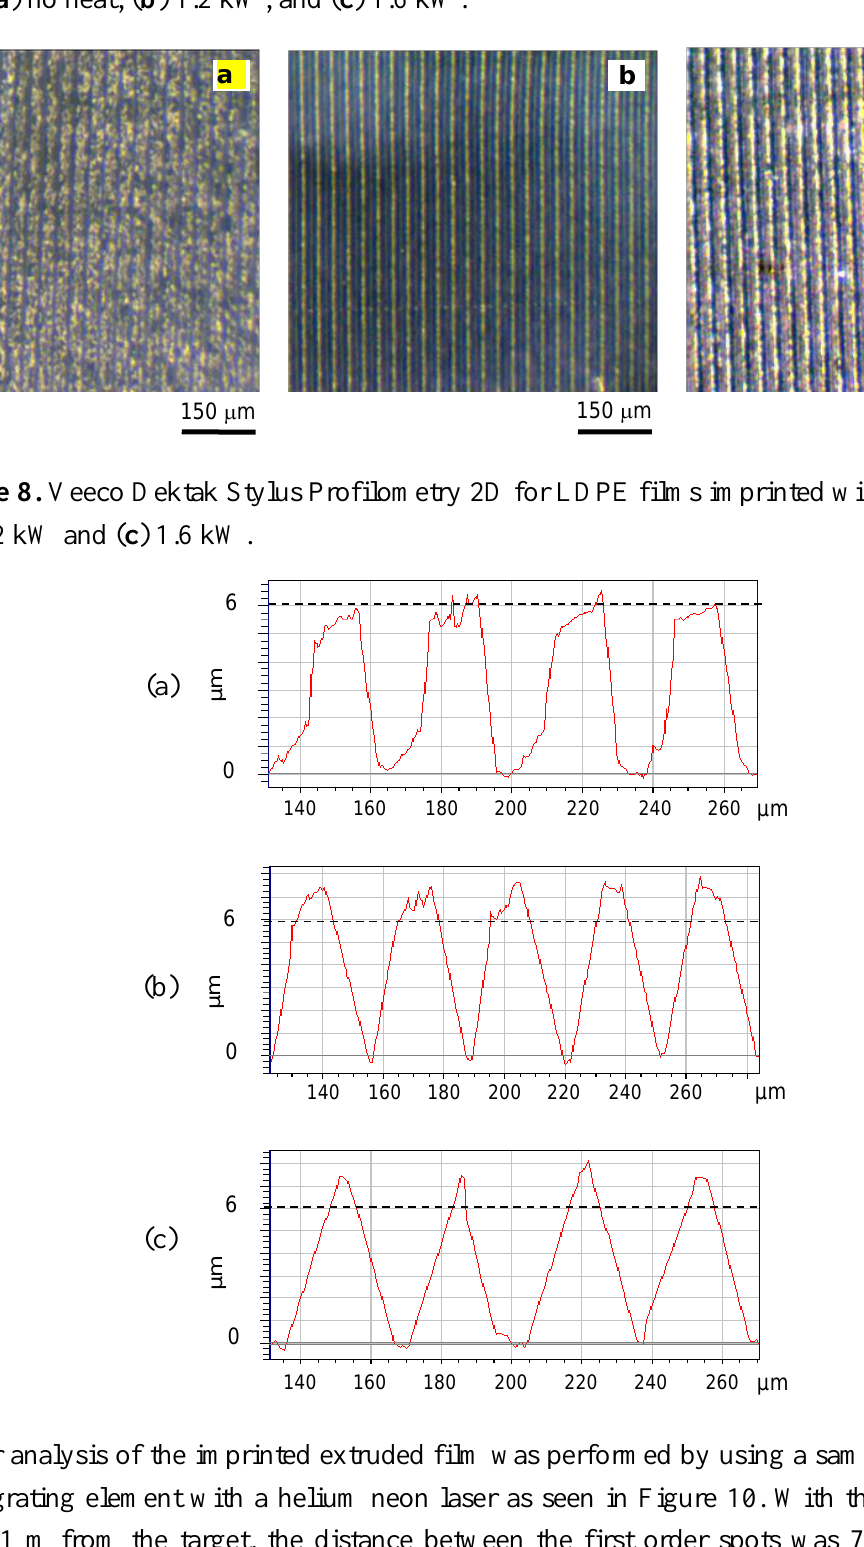
Figure 7. Digital microscopy images for low-density polyethylene (LDPE) films imprinted with ( a ) no heat; ( b ) 1.2 kW; and ( c ) 1.6 kW.